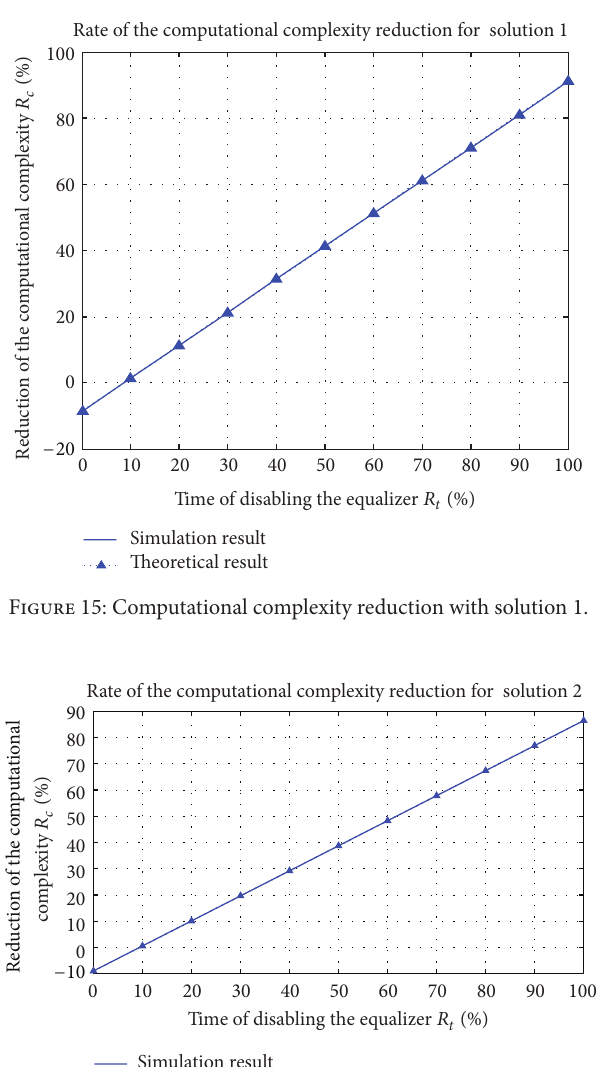
Simulation result Theoretical F 16: Computational complexity reduction with solution